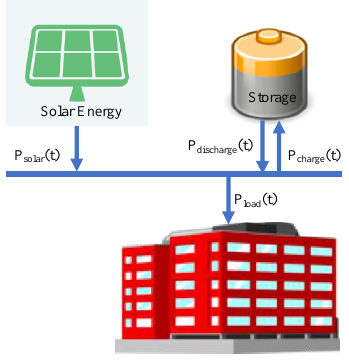
Figure 3. Islanded microgrid architecture with solar energy and battery